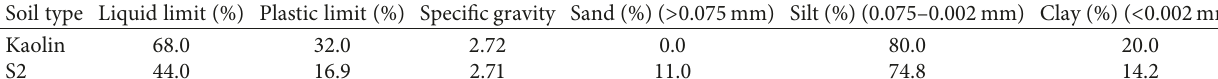
Table 1: Physical parameters of kaolin and soil S2 used in this study.